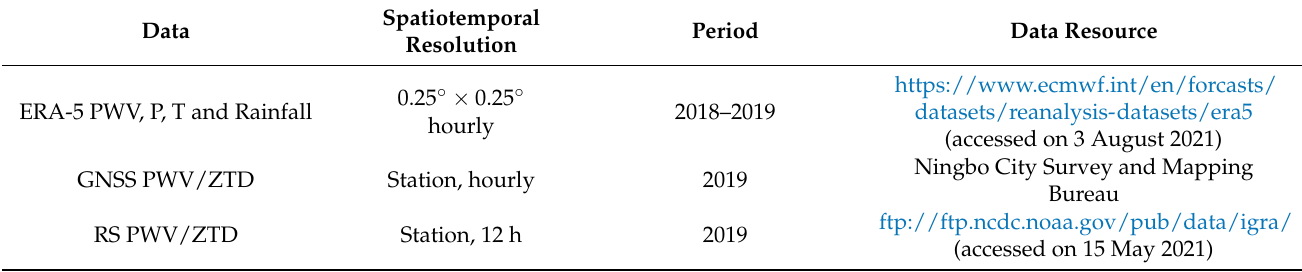
Table 2. Sources of data selected in this